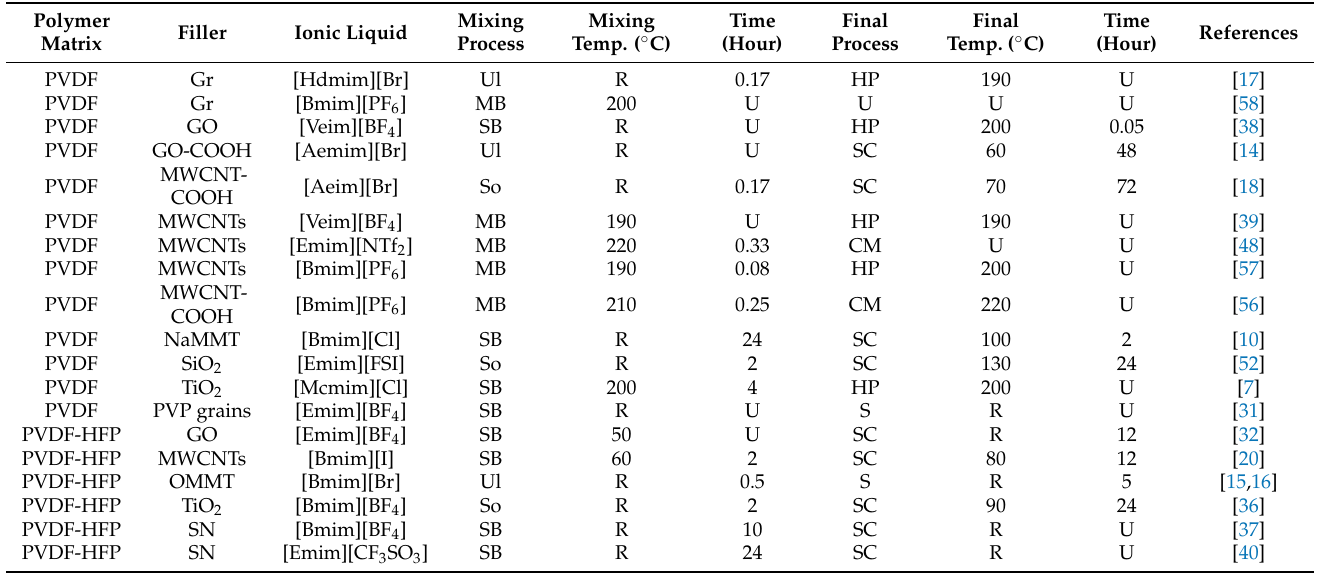
Table 6. Types of polymer matrices, fillers, imidazolium-based ionic liquids, and preparation processes of PVDF and PVDF-HFP